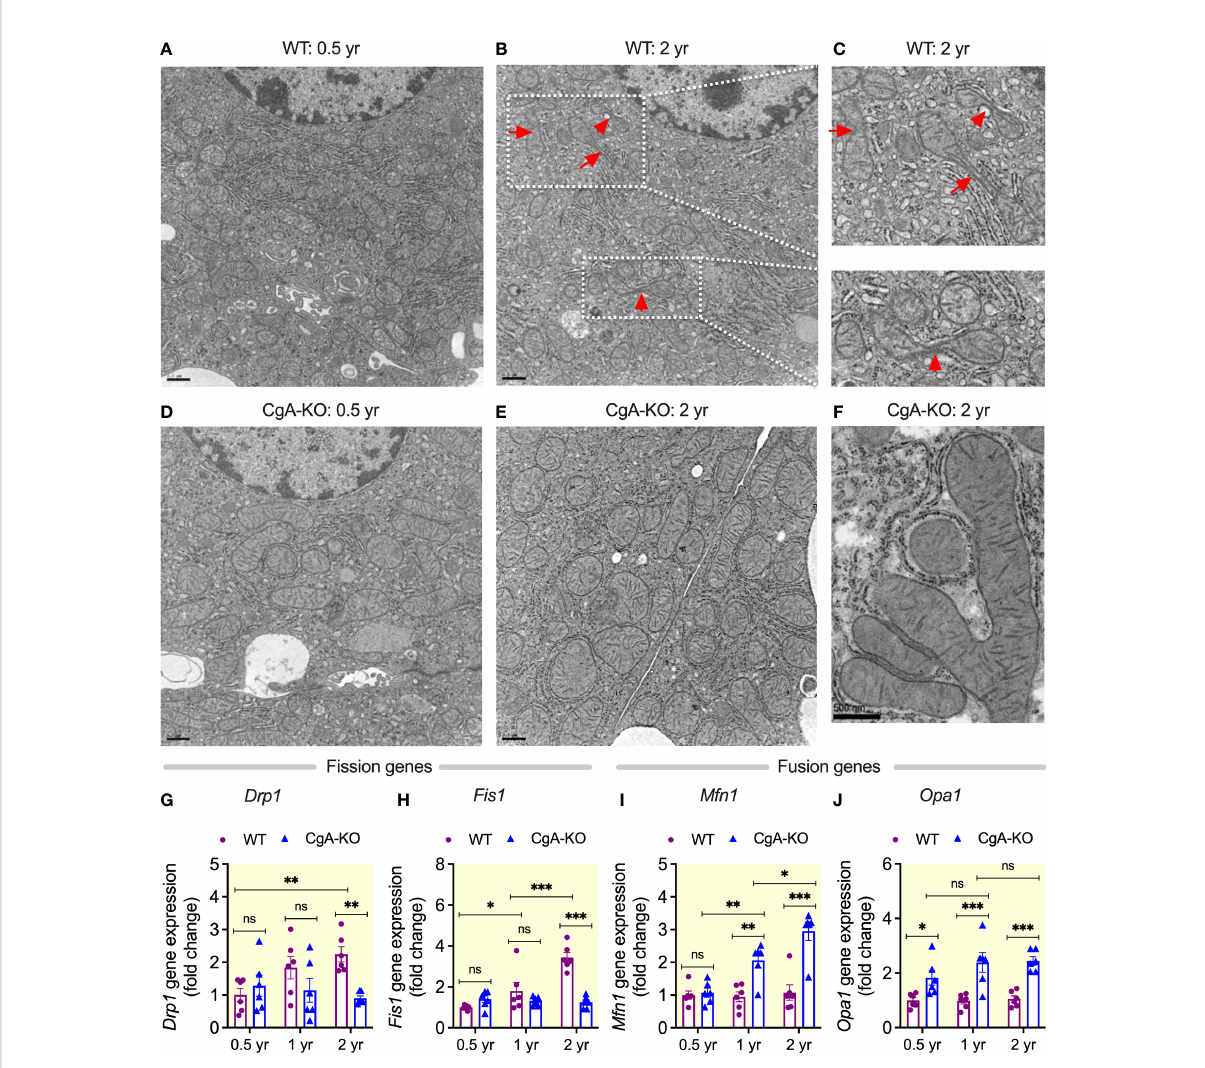
FIGURE 7 Increased mitochondrial fusion in aging CgA-KO mice. Electron micrographs of liver sections: (A – C) Mitochondrial fi ssion in aging WT mice. (D – F) Mitochondrial fusion in aging CgA-KO mice. Scale bars: 0.5 µm (A, B, D, E) . Expression of mitochondrial fi ssion genes in the liver of WT and CgA-KO mice: (G) Drp1 . 2-way ANOVA: Interaction: p<0.05; Age: ns; Genotype: p<0.05. (H) Fis1 . 2-way ANOVA: Interaction: p < 0.001; Age: p < 0.001; Genotype: p < 0.001. Expression of mitochondrial fusion genes: (I) Mfn1 . 2-way ANOVA: Interaction: p < 0.001; Age: p < 0.001; Genotype: p < 0.001. (J) Opa1 . 2-way ANOVA: Interaction: ns; Age: ns; Genotype: p < 0.001. *P < 0.05; **P < 0.01; ***P <